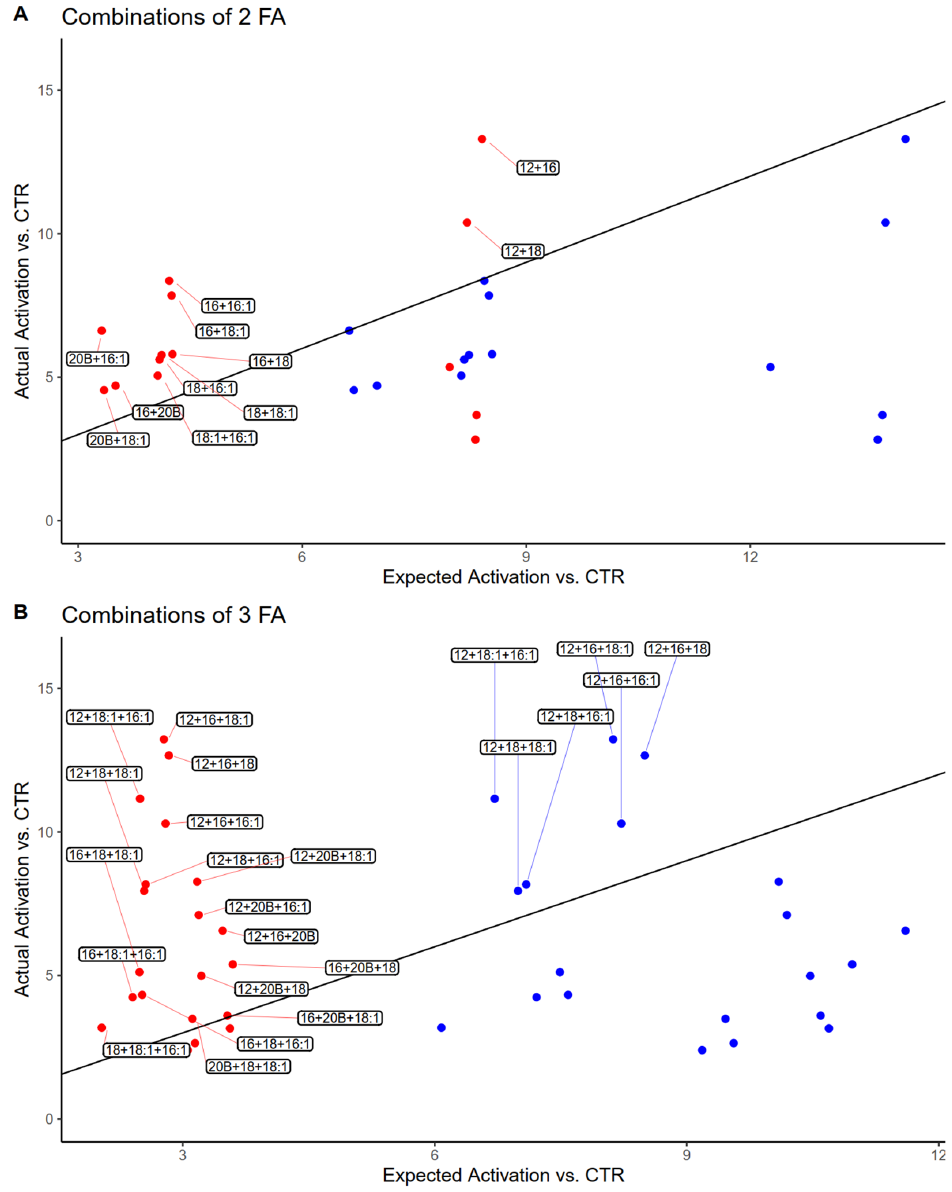
Figure 4. Dot plot comparing mean of experimentally measured PPAR activation by combinations of two ( A ) or three ( B ) fatty acids, when compared to the hypothetical weighted average model (red dots) and additive model (blue dots). Diagonal line represents threshold where ratio of actual/expected activation is equal to 1. Labeled in the figure: mixtures with an actual/expected activation ratio greater than one. (12 = dodecanoic acid; 16 = palmitic acid; 16:1 = palmitoleic acid; 18 = stearic acid; 18:1 = oleic acid; 20B = phytanic acid).